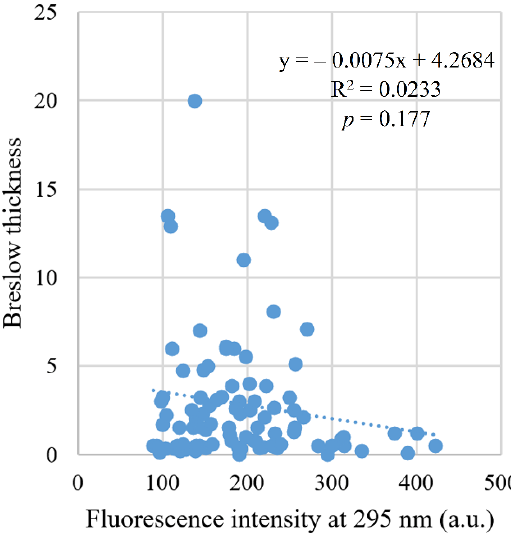
Figure 7. Correlation between fluorescence intensity and Breslow thickness.